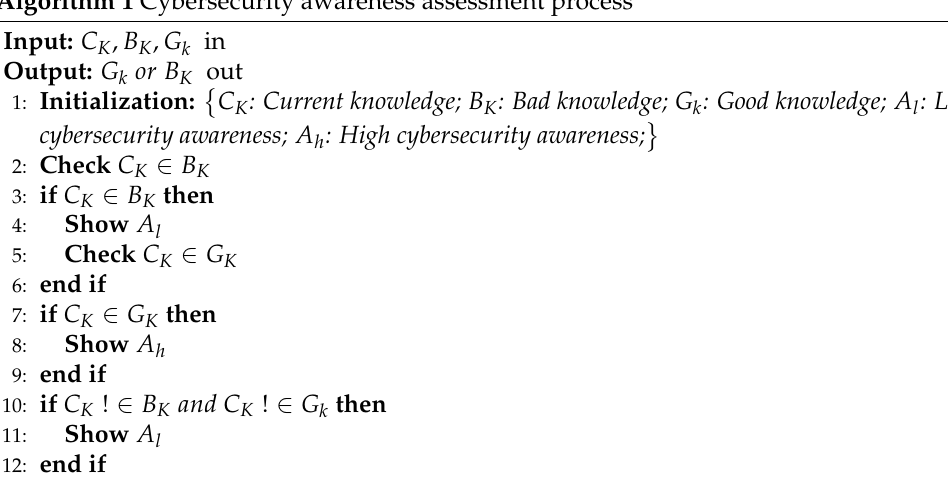
Algorithm 1 Cybersecurity awareness assessment